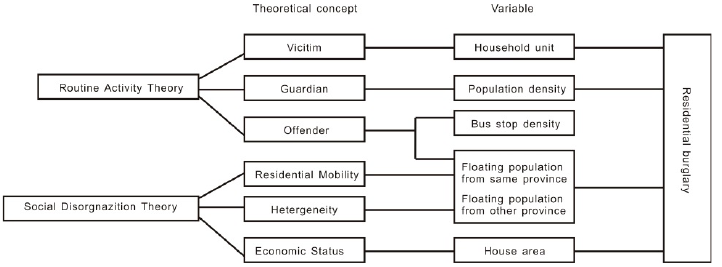
Figure 2. Conceptual framework of model development.